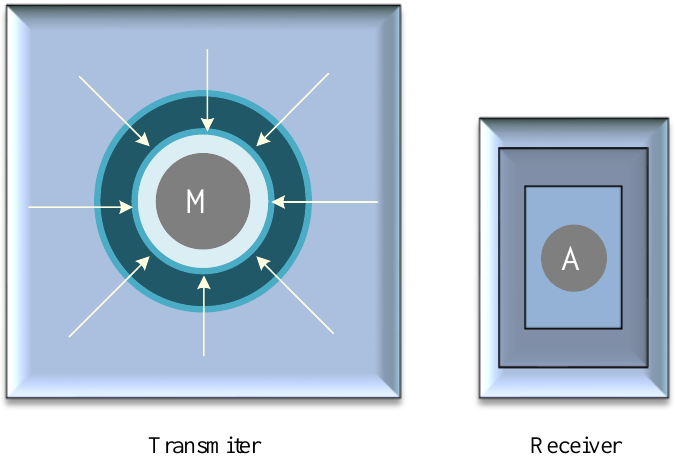
Figure 12. Transmitter with guided positioning.